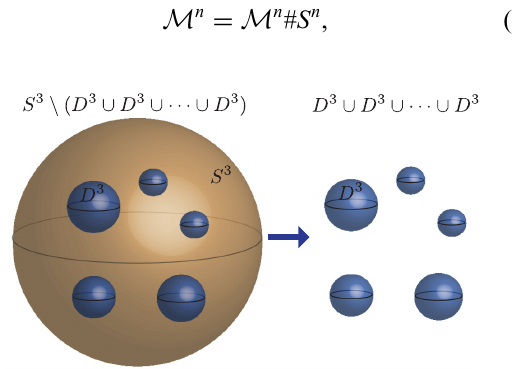
FIG. 37. An illustration for the application of the Alexander duality: the first homology of the punctured 3-sphere (with inte- rior holes homeomorphic to 3-balls D 3 ) is isomorphic to the first homology of the union of the 3-balls D 3